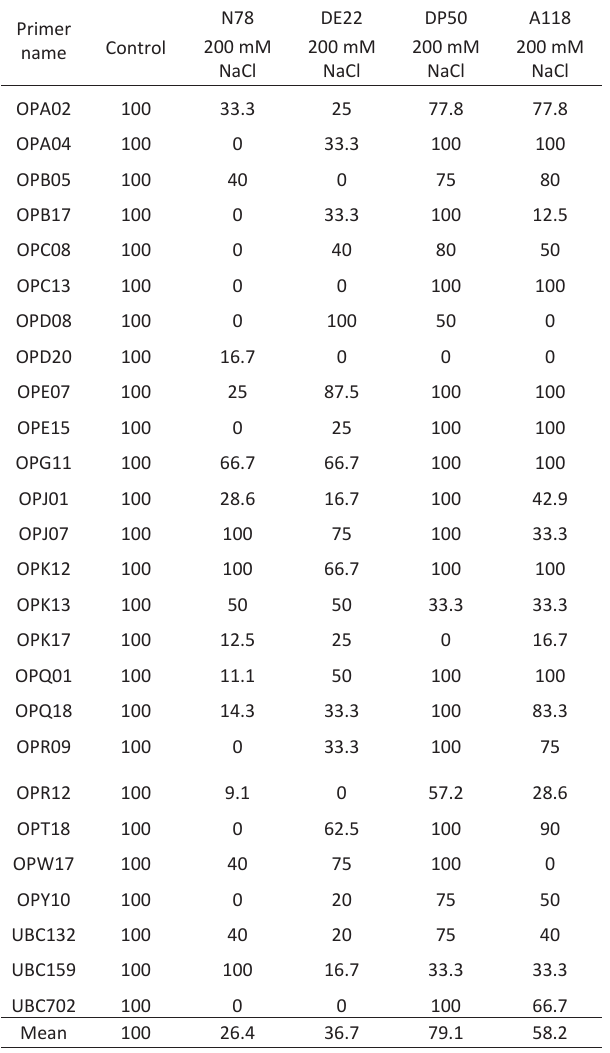
Fig. 1 - RAPD banding profiles generated by OPA02, OPB17 and OPY10 primers in the four tested cotton varieties showing DNA changes induced by NaCl application for seven weeks, C: Control, T: Treated plants. M: 1 kb DNA Ladder Mix, ready for use. Table 3 - Genomic Template Stability (GTS%) estimated by 26 RAPD primers for the four tested cotton varieties under salt stress compared to their respective